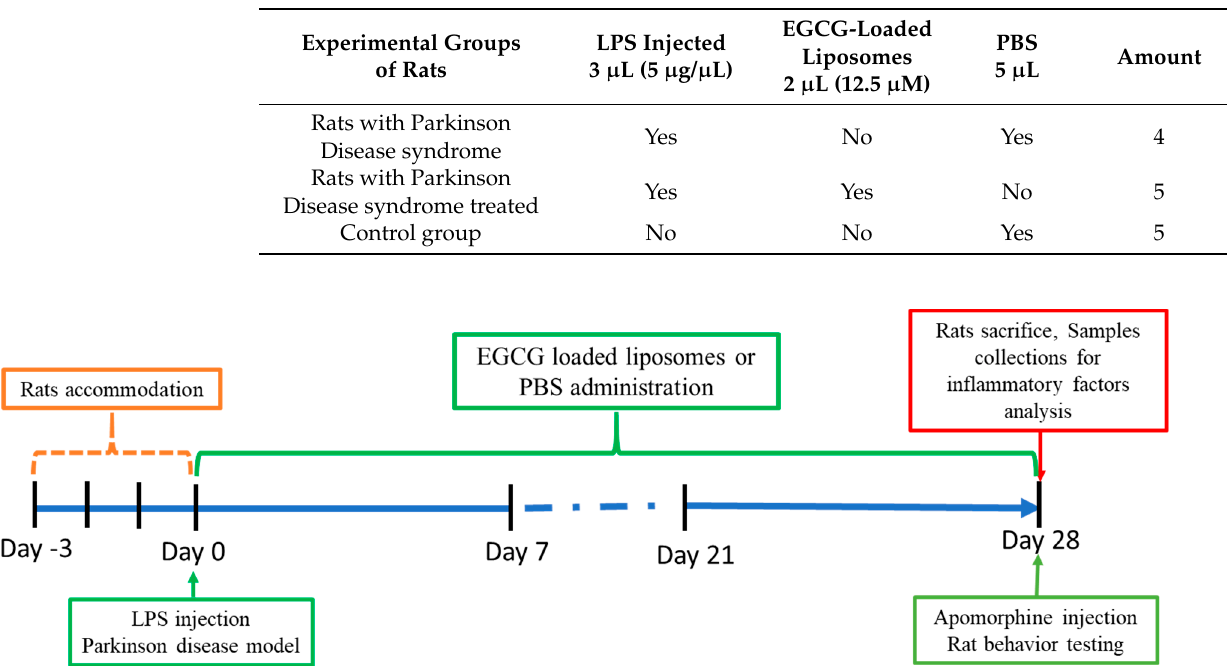
Table 2. Rat groups and treatment administered.